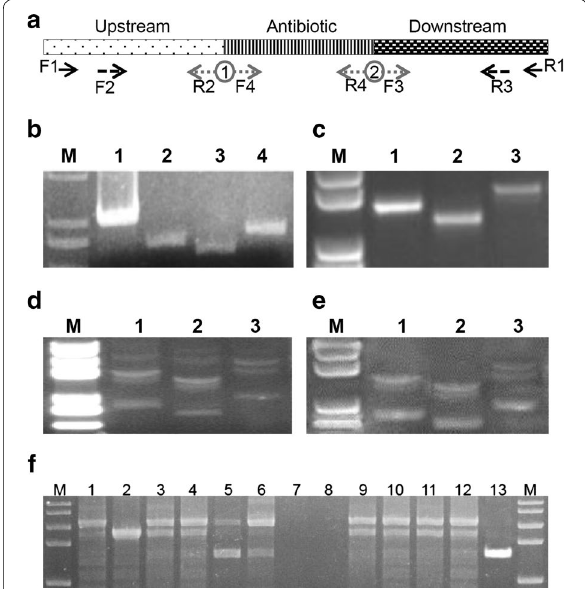
Fig. 2 Cassette construction and colony PCR. a Primer location of the enhanced VFAE protocol. b DNA fragments of the antibiotic cassette and the three different overlapping homologous fragments before ligation. c Three DNA cassettes after ligation. d Ligation product of the VFAE protocol. e Ligation product of the enhanced VFAE protocol. f Colony PCR of the enhanced VFAE protocol; lane 13 shows the wild- type